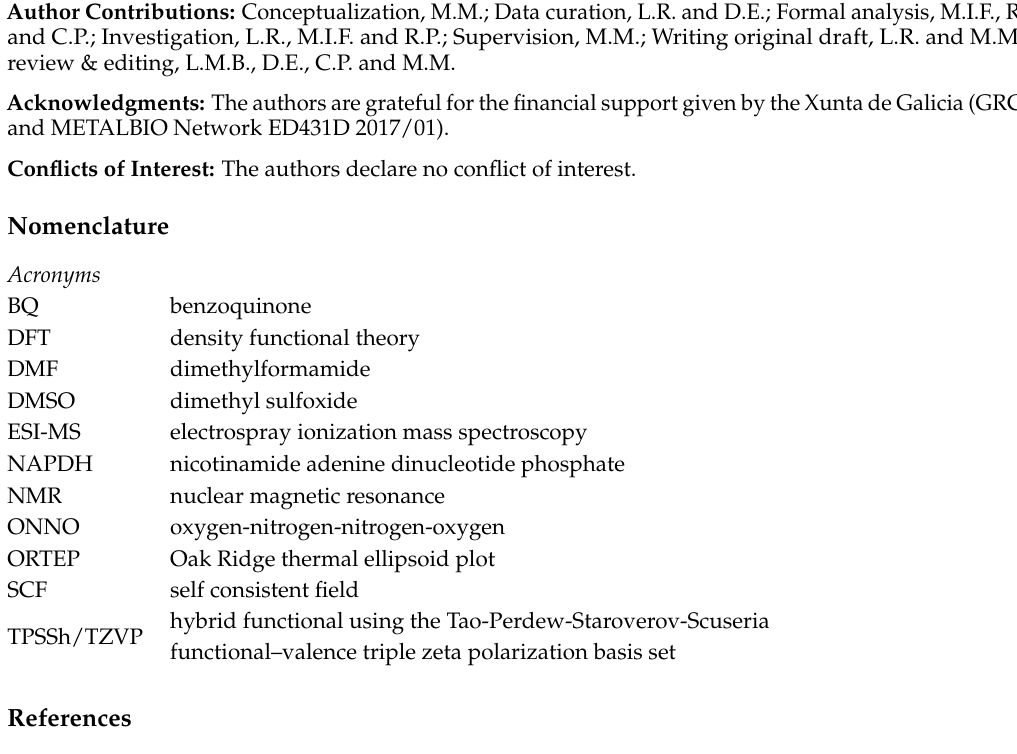
[ ◦ ] for 1 ; Table S6: Atomic coordinates ( × 10 4 ) and equivalent isotropic displacement parameters (Å 2 × 10 3 ) for 2 ; Table S7: Bond lengths [Å] and angles [ ◦ ] for 2 ; Table S8: Anisotropic displacement parameters (Å 2 × 10 3 ) for 2 ; Table S9: Hydrogen coordinates ( × 10 4 ) and isotropic displacement parameters (Å 2 × 10 3 ) for 2; Table S10: Torsion angles [ ◦ ] for 2 . Table S11: Optimized Cartesian Coordinates (Å) obtained with DFT calculations (TPSSh/TZVP) for the [MnL 1 ]-2H2O system; Table S12: Optimized Cartesian Coordinates (Å) obtained with DFT calculations (TPSSh/TZVP) for the {[MnL 1 ]-2H2O}2 system; Scheme S1. Chemdraw structures for 1 and 2 ; Figure S1: Paramagnetic 1 H NMR spectrum for complex 1; Figure S2: ESI mass spectrum for complex 2 ; Figure S3: IR spectrum for 2